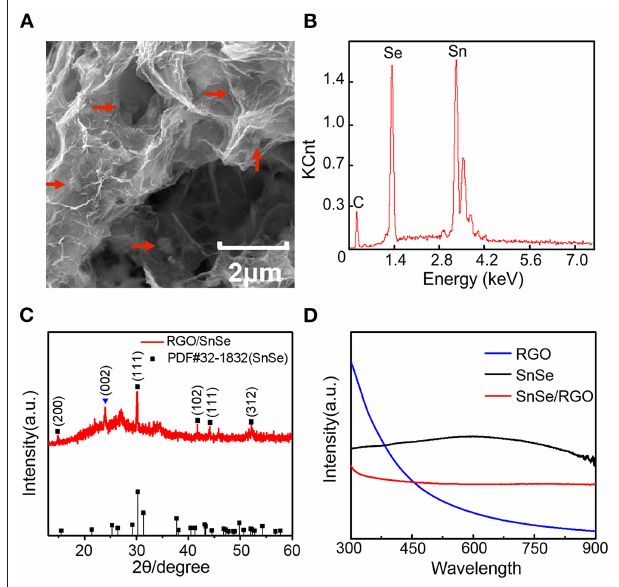
FIGURE 1 | (A) SEM image of the SnSe/RGO nanohybrid. (B) Energy dispersive X-ray spectroscopy of the SnSe/RGO hybrid. (C) XRD pattern of the SnSe/RGO nanohybrid. (D) UV-vis absorption spectra of the SnSe nanosheets (black line), SnSe/RGO nanohybrid (red line), and RGO nanosheets (blue